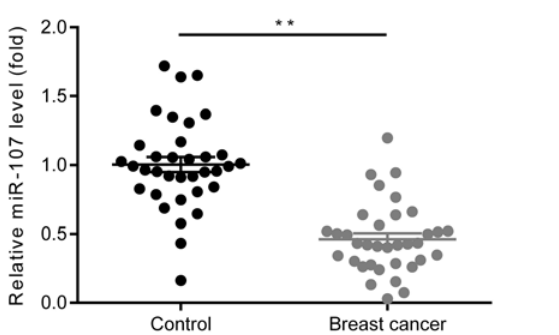
Figure 1: The expression level of miR-107 is down-regulated in breast cancer tumor tissues. The relative expression level of miR-107 in breast cancer tumor tissues and non-tumor adjacent tissues were compared via RT-qPCR assay. **P<0.01, vs control group. Control, non-tumor adjacent tissues; breast cancer, breast cancer tumor tissues; miR-107,